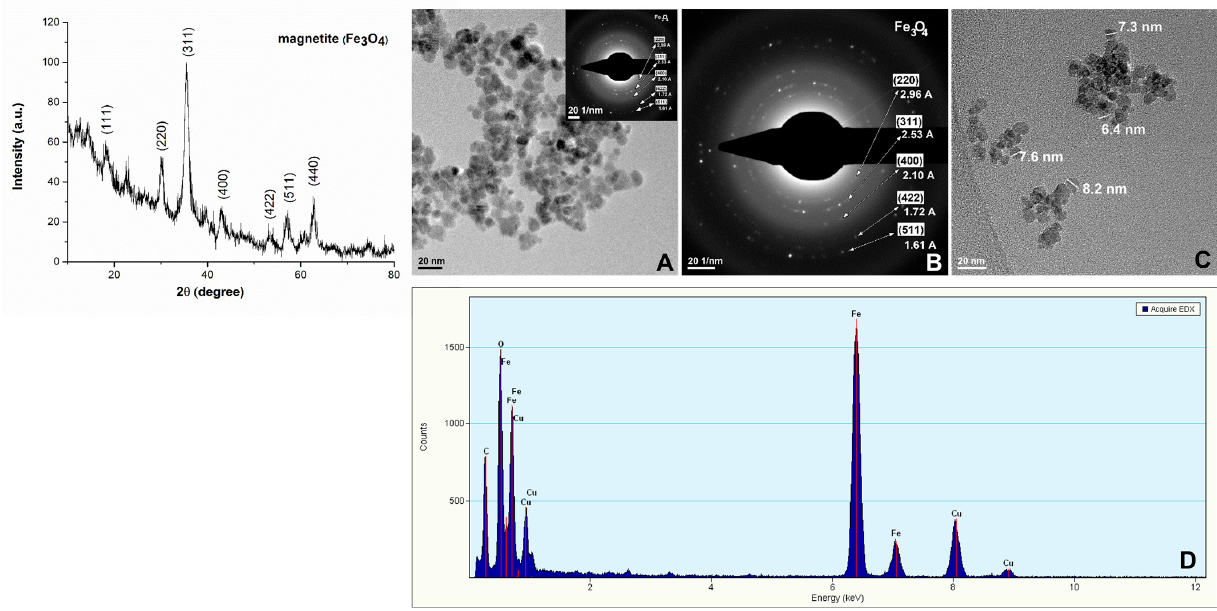
Figure 1. X-ray diffractogram and TEM characterization for magnetite nanoparticles: ( A , C )—bright- field TEM images (BF-TEM); ( B )—electron diffraction (SAED); ( D )—Energy-dispersive X-ray anal- ysis (EDAX).